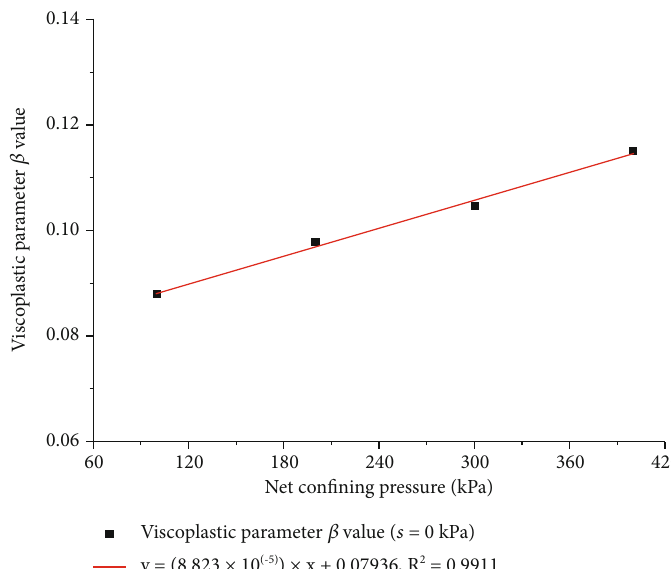
Figure 10: Relationship between β value of reticulate red clay and net con fi ning pressure